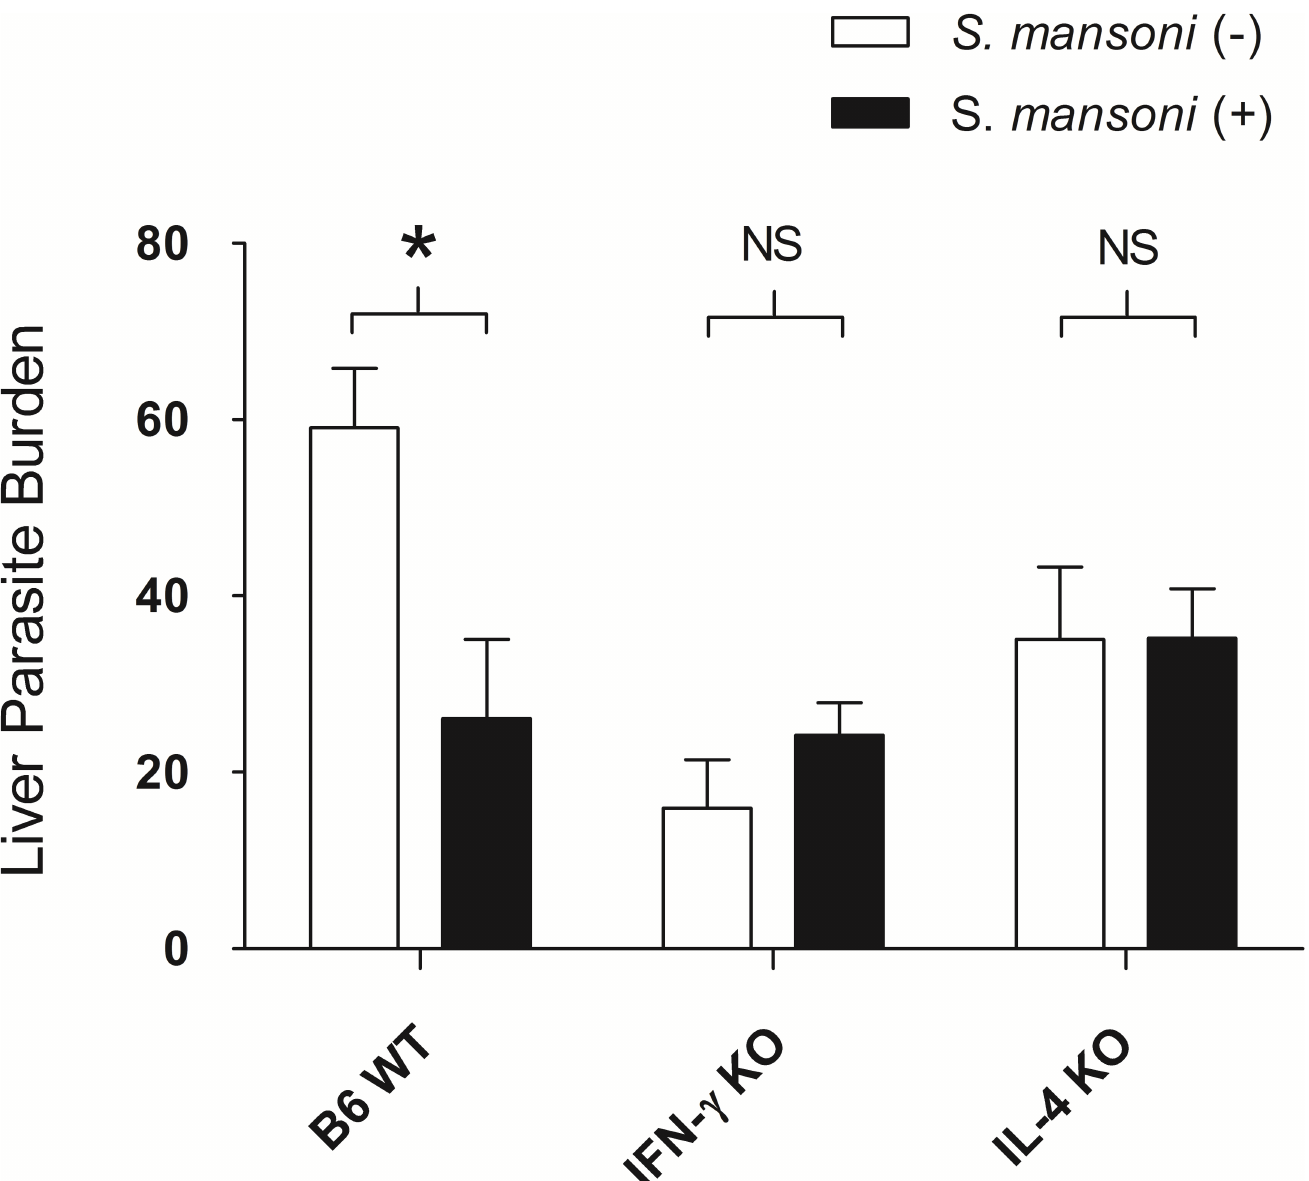
Fig 5. Malaria parasite liver burden in wild-type B6, IFN-gamma-deficient, and Interleukin-4-deficient mice. Copy number of Plasmodium yoelii 18s RNA gene per 1×10 6 mouse G3PDH gene measured at 42 h post sporozoite inoculation. Female IFN- γ -/- mice (N = 8), IL-4 -/- mice (N = 8), and B6 WT mice (N = 4) were intraportally inoculated with 3,000 frozen S . mansoni -eggs and challenged with 1,500 SPZ of P . yoelii along with each control groups inoculated 100 μL PBS (N = 4). B6 WT mice: (cid:3) P < 0.05, t = 3.017, df = 5; IFN- γ -/- mice: Not significant (NS), t = -1.303, df = 10; IL-4-/- mice: NS, t = -0.016, df =